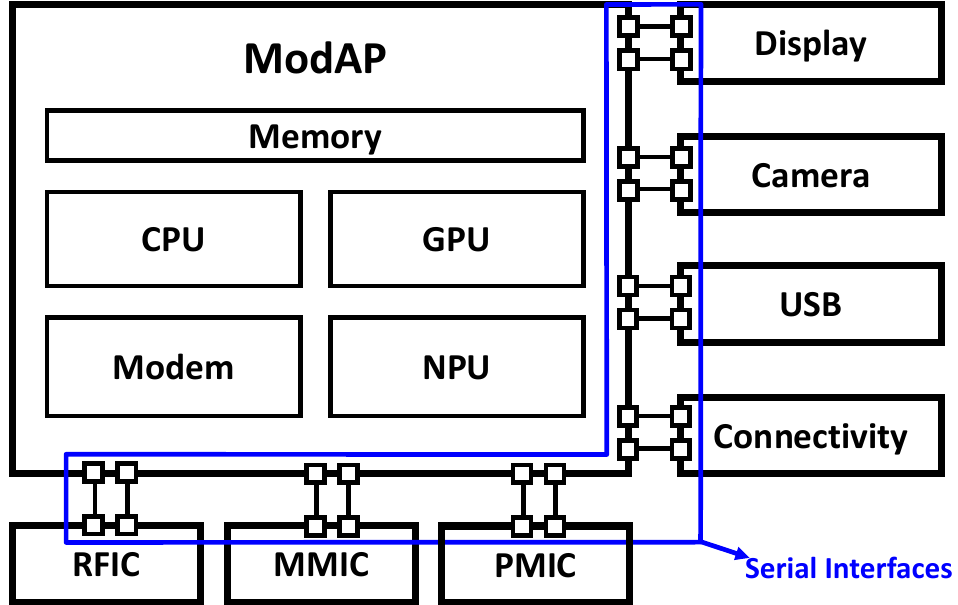
Figure 1. Architecture of cellular phone using serial interface